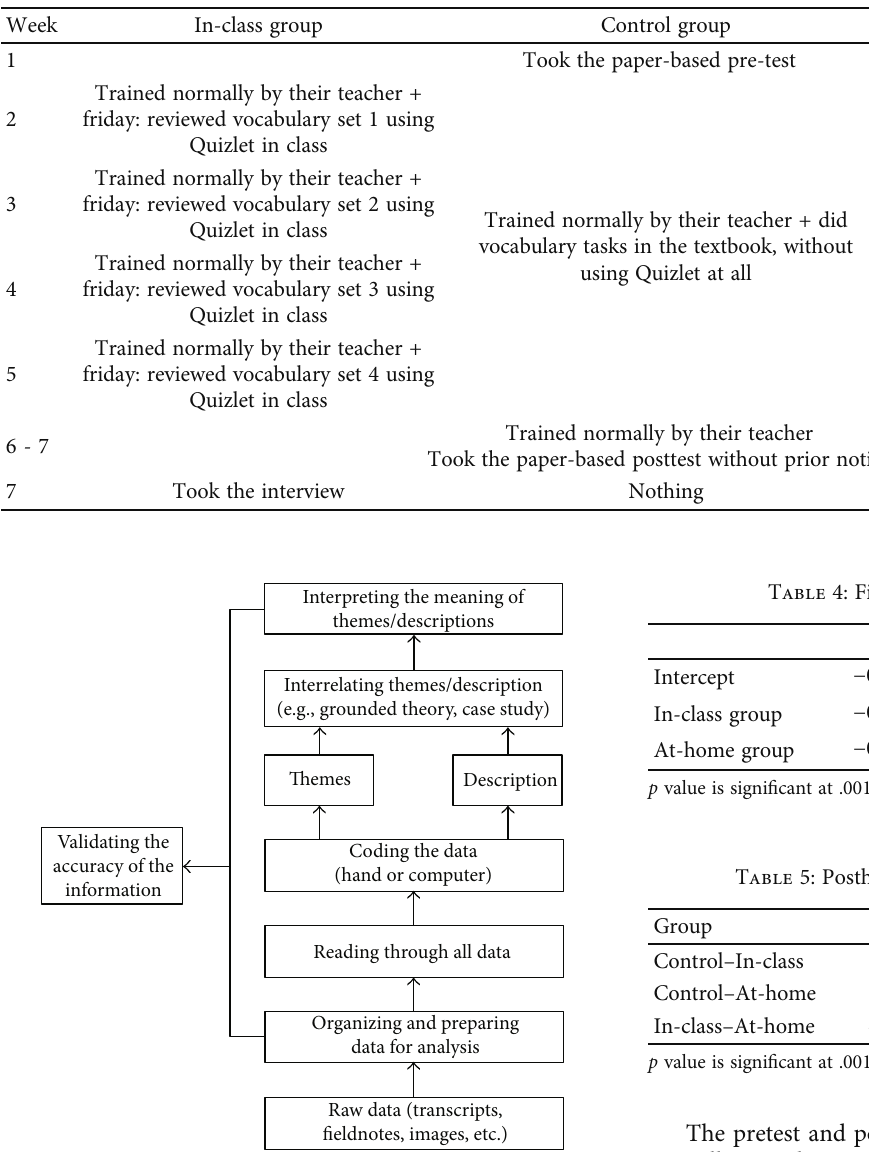
Table 2: Data collection procedure.